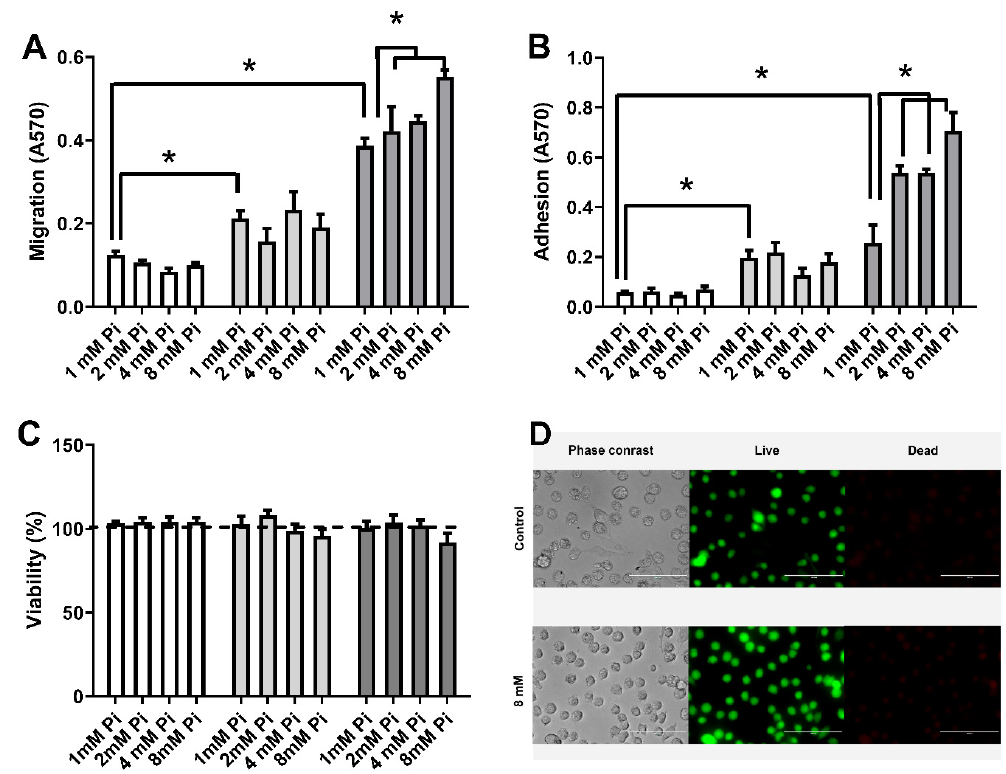
Figure 3. Effect of high Pi concentrations on the migration, adhesion to ECM and viability of the breast cell lines. Different breast cell lines: MCF10-A (white bars), MCF-7 (grey bars), and MDA-MB-231 (dark grey bars) were treated with various Pi concentrations (1, 2, 4 and 8 mM Pi) for 24 h. Migration ( A ), adhesion to ECM ( B ), and cell viability by MTS assay ( C ) were evaluated as described in Section 4. Bars represent mean ± SE of at least three independent biological samples. * p < 0.05 indicates changes significantly different, as assessed by ANOVA followed by Tukey’s multiple comparison test. Representative images of MDA-MB-231 cells treated with 1 mM (control) or 8 mM Pi for 24 h. Corresponding phase contrast images (left panels) and viability images (live/dead assay, green cells are alive and red cells are dead, right panels). Bars: 100 µ m ( D ).